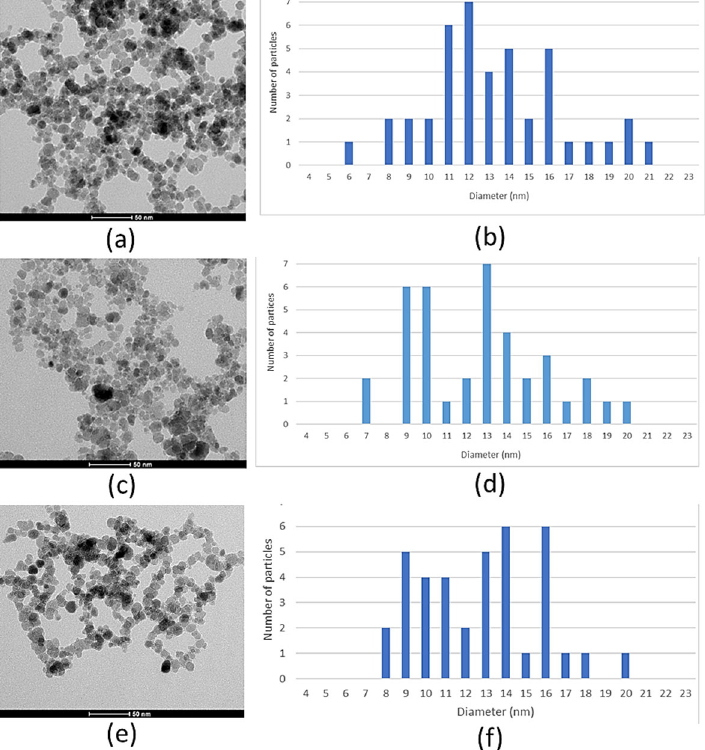
Figure 1. ( a ) TEM image of bare Fe 3 O 4 , ( b ) particle size distribution of bare Fe 3 O 4 , ( c ) TEM image of NH 2 ‐ Fe 3 O 4 , ( d ) particle size distribution of NH 2 ‐ Fe 3 O 4 , ( e ) TEM image of citrate ‐ 80C ‐ Fe 3 O 4 , and ( f ) particle size distribution of citrate ‐ 80C ‐ Fe 3 O 4 .